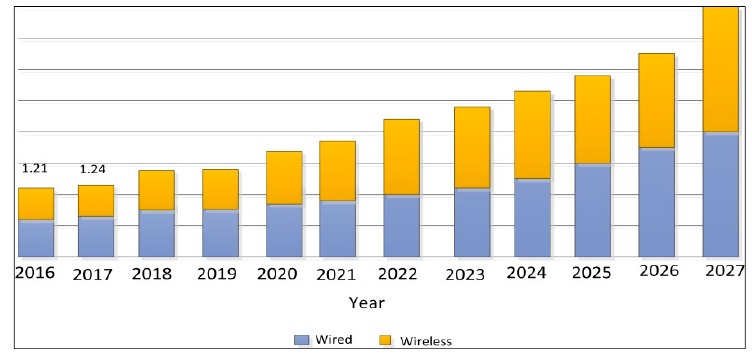
Figure 1. Security camera market size.